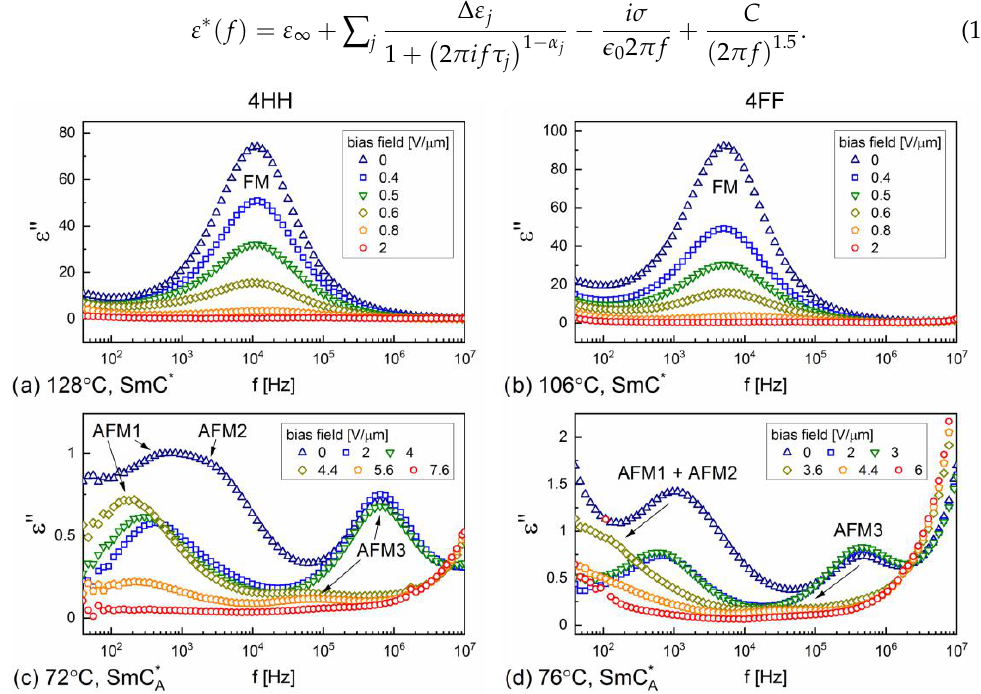
Figure 7. Dielectric absorption in the SmC ∗ ( a , b ) and SmC A∗ ( c , d ) phases of 4HH ( a , c ) and 4FF ( b , d ) without and with the external bias field applied.